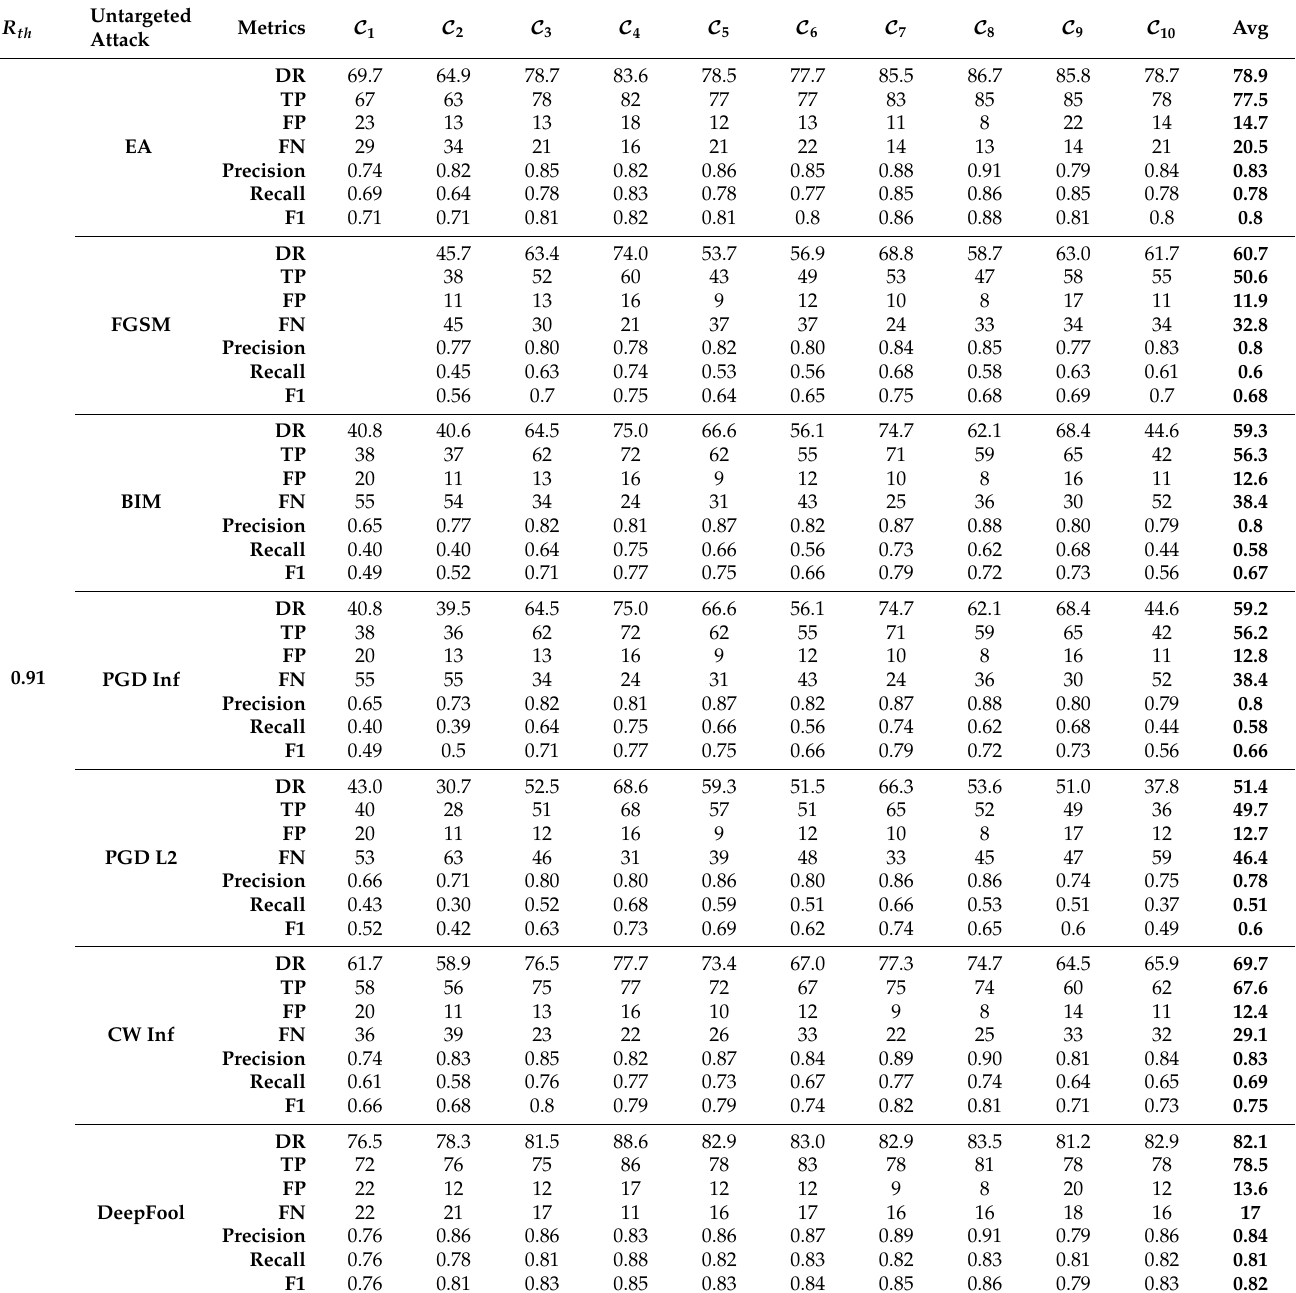
Table 12. Untargeted attacks—DR as a percentage, and TP, FP, FN, precision, recall, F1 scores per CNN per attack for each selected value of R th = 0.91, and their corresponding